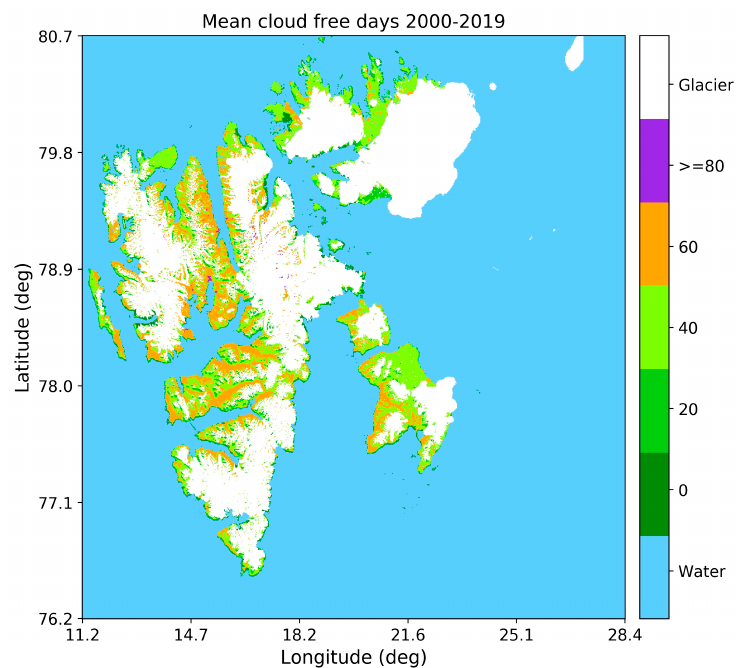
Figure A1. Average number of cloud-free days per year.